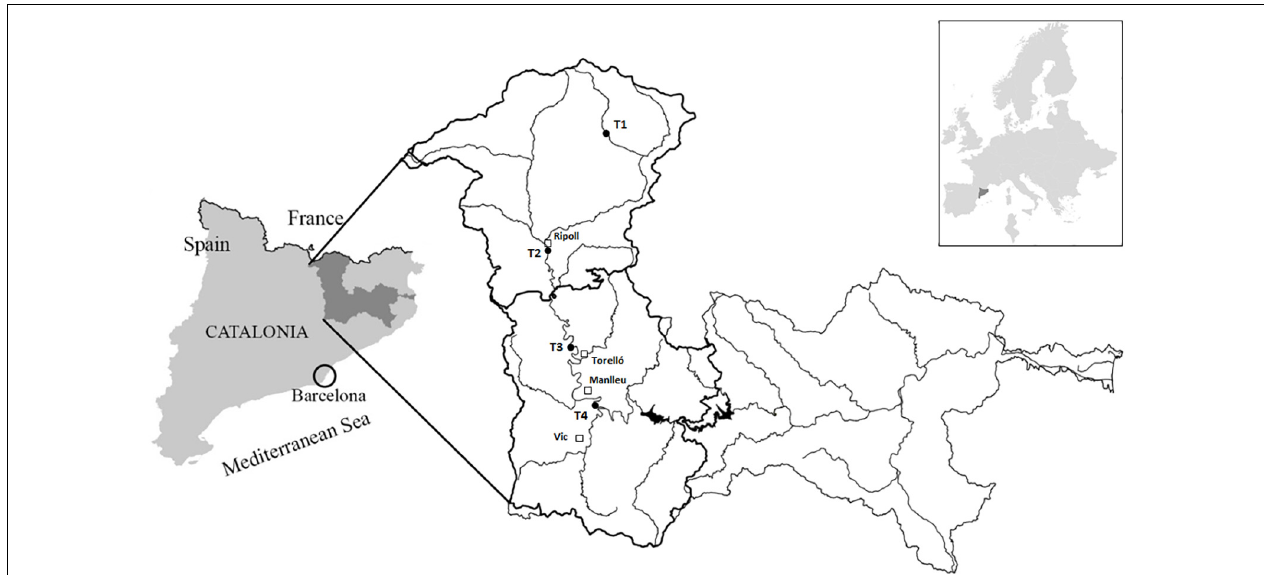
FIGURE 1 | Ter River basin and sampling sites located in upper part (El Ripollès and Osona regions): T1 = Ter at Vilallonga de Ter municipality, T2 = Ter downstream Ripoll municipality, T3 = Ter at Colónia de Borgonyà (Sant Vicenç de Torelló municipality), and T4 = Ter at Gurb